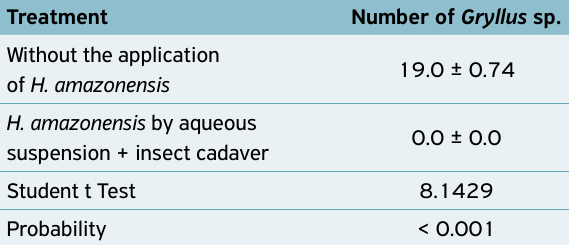
Table 4. Occurrence of Gryllus sp. in area cultivated with vegetables before and after the application of Heterorhabditis amazonensis MC01. Number of Gryllus